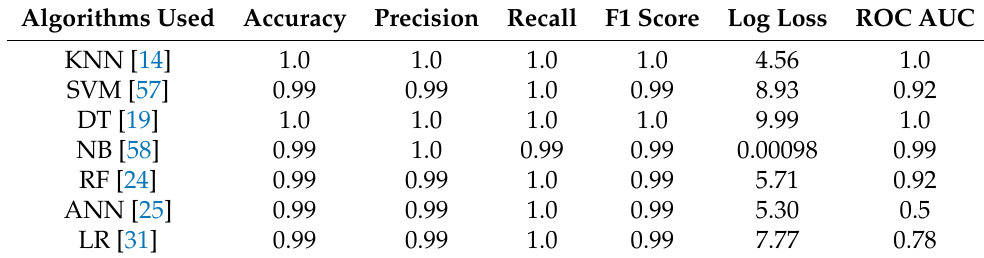
Table 18. DDoS UDP results.